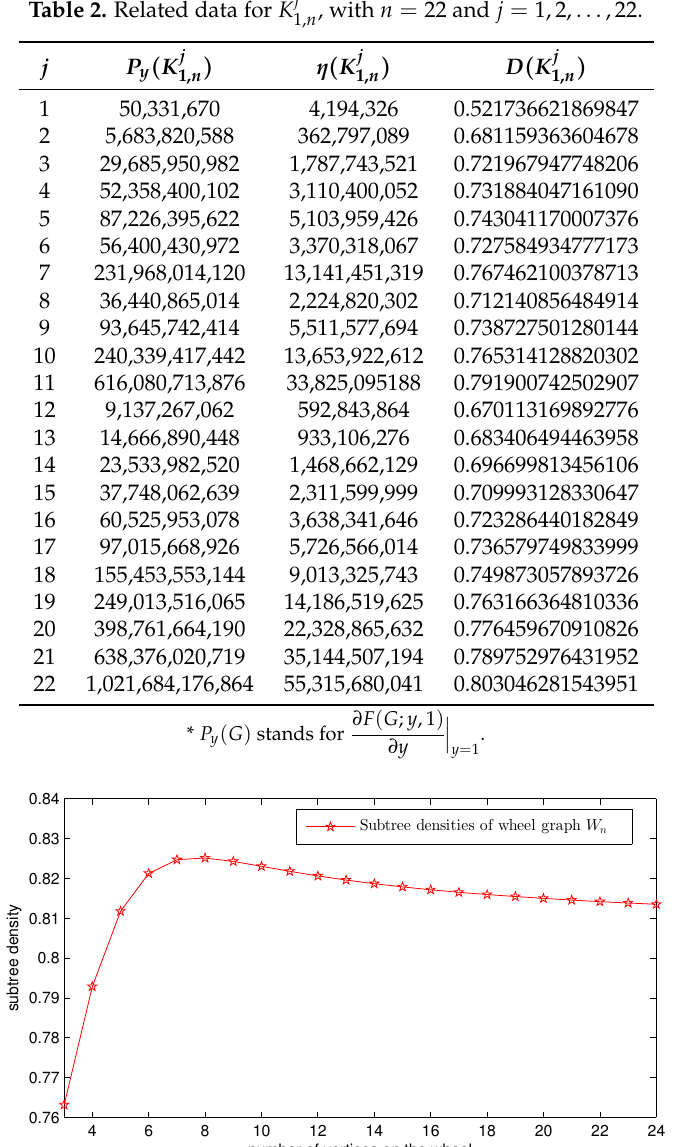
Table 2. Related data for K j